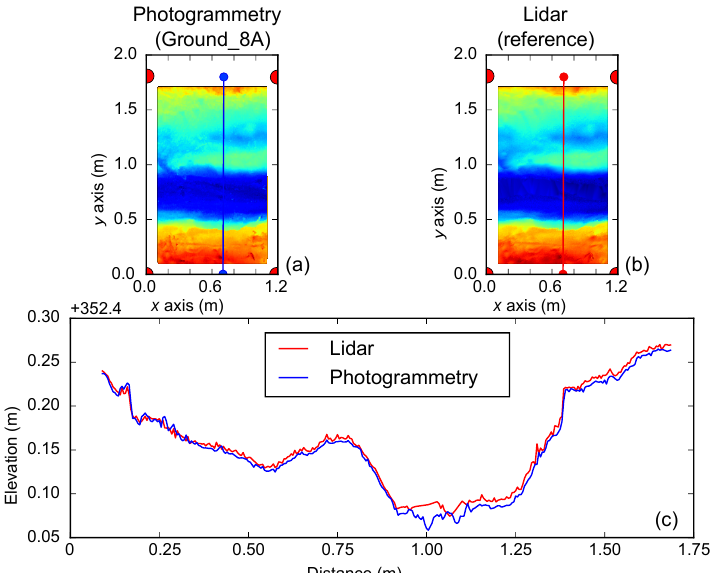
Figure 11. Illustration of three-dimensional point cloud interpolation into raster grids for volume and cross-sectional analysis of gully monitoring and geomorphologic quantification. Direct comparison of Ground_8A photogrammetry (a) and lidar (b) raster grid data with a highlight of one specific cross section (c) . The cross section can be realized anywhere within the